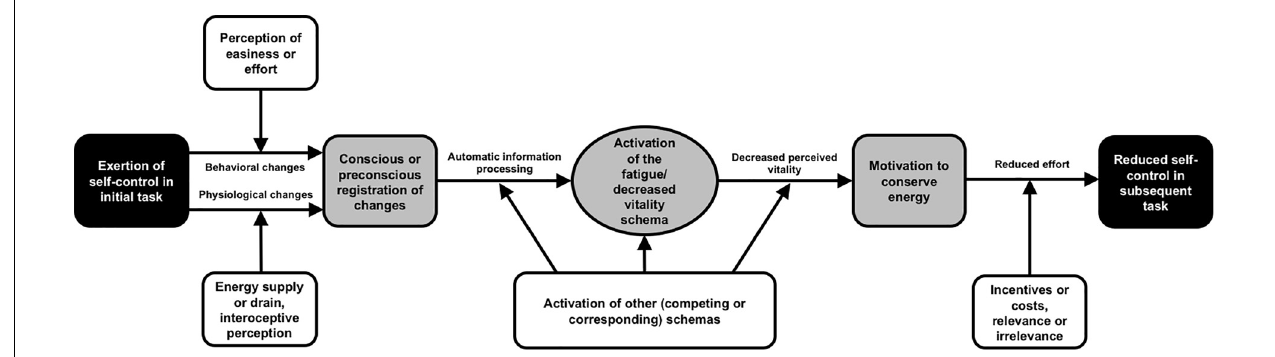
FIGURE 1 | The schema model of self-control (Figure taken from Bertrams, 2020). Black boxes: the observable behavior in self-control studies. Gray boxes and horizontal arrows: the mediating processes within the individual. White boxes: moderating variables.